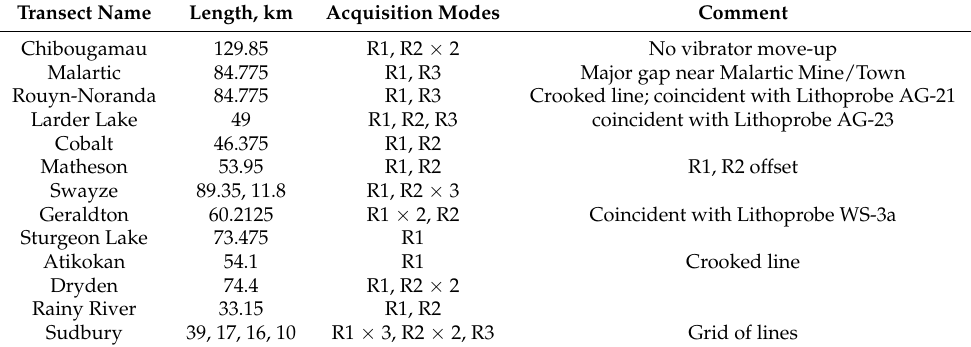
Table 2. Individual transects of Metal Earth, including both regional and high-resolution modes.